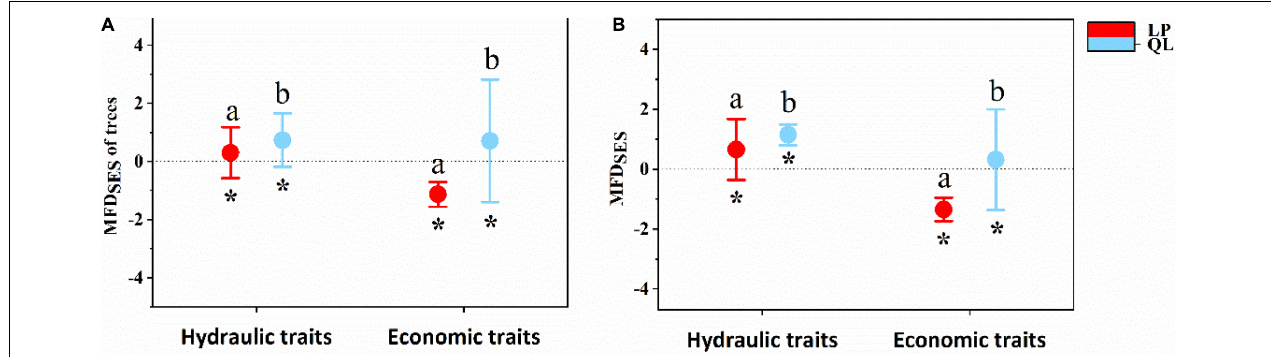
FIGURE 6 | The difference of community functional structure [standardized effect size (SES)] based on multiple traits between the Loess Plateau (LP) and the Qinling Mountain (QL). (A) Test on multiple hydraulic and economic traits in tree stratum. (B) Test on multiple hydraulic and economic traits in the whole site. Standardized effect size > 0 represents functional divergence, whereas SES < 0 indicates functional convergence. Red point and blue point show the mean SES values within the LP and the QL. Error bars represent standard errors. Asterisks indicate significant differences between SES with 0. Different letters above bars (ab) indicate statistically significant differences at P < 0.05 between the LP and the QL in the same